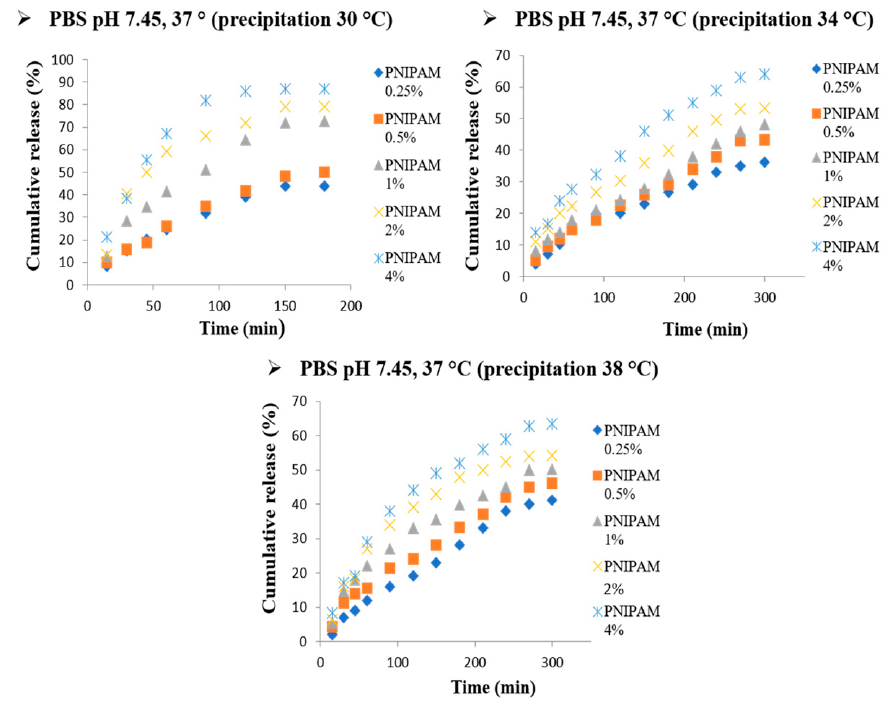
Figure 5. Doxorubicin release profiles from PNIPAM/magnetite nanoparticles in PBS at pH 7.45 and 37 ◦ C (precipitation temperatures 30, 34, and 38 ◦ C). Table 3. Release efficiency of doxorubicin in PNIPAM/magnetite nanoparticles. Precipitation Temperature ( ◦